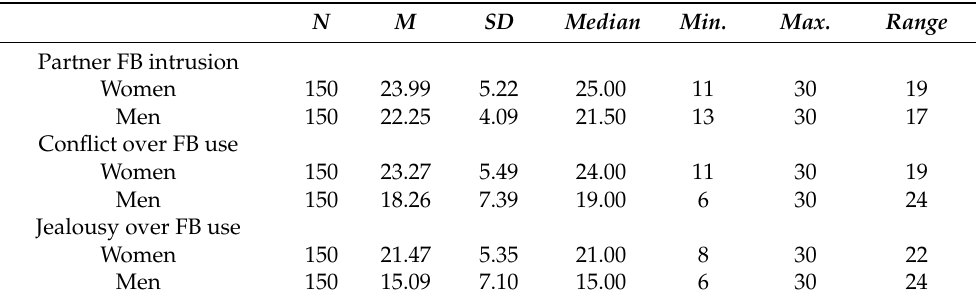
Table 6. Descriptive data of the measures across sex.